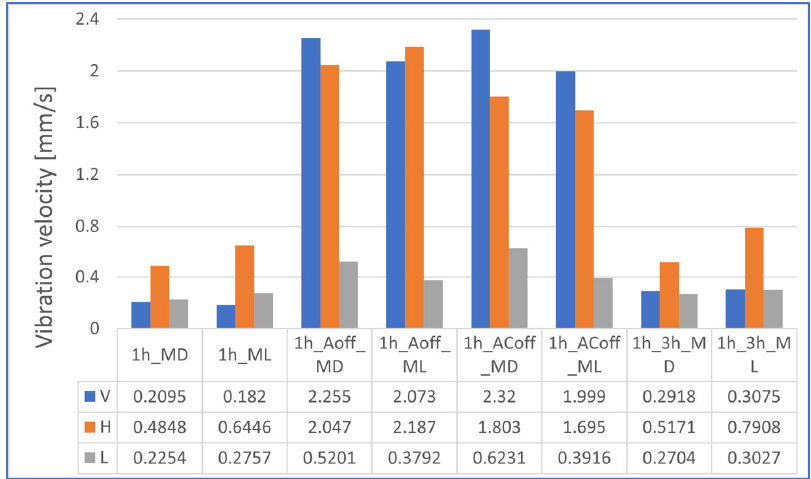
Figure 8. Vibration RMS distribution characteristics for a loaded motor and a rotational speed of 150 rpm.